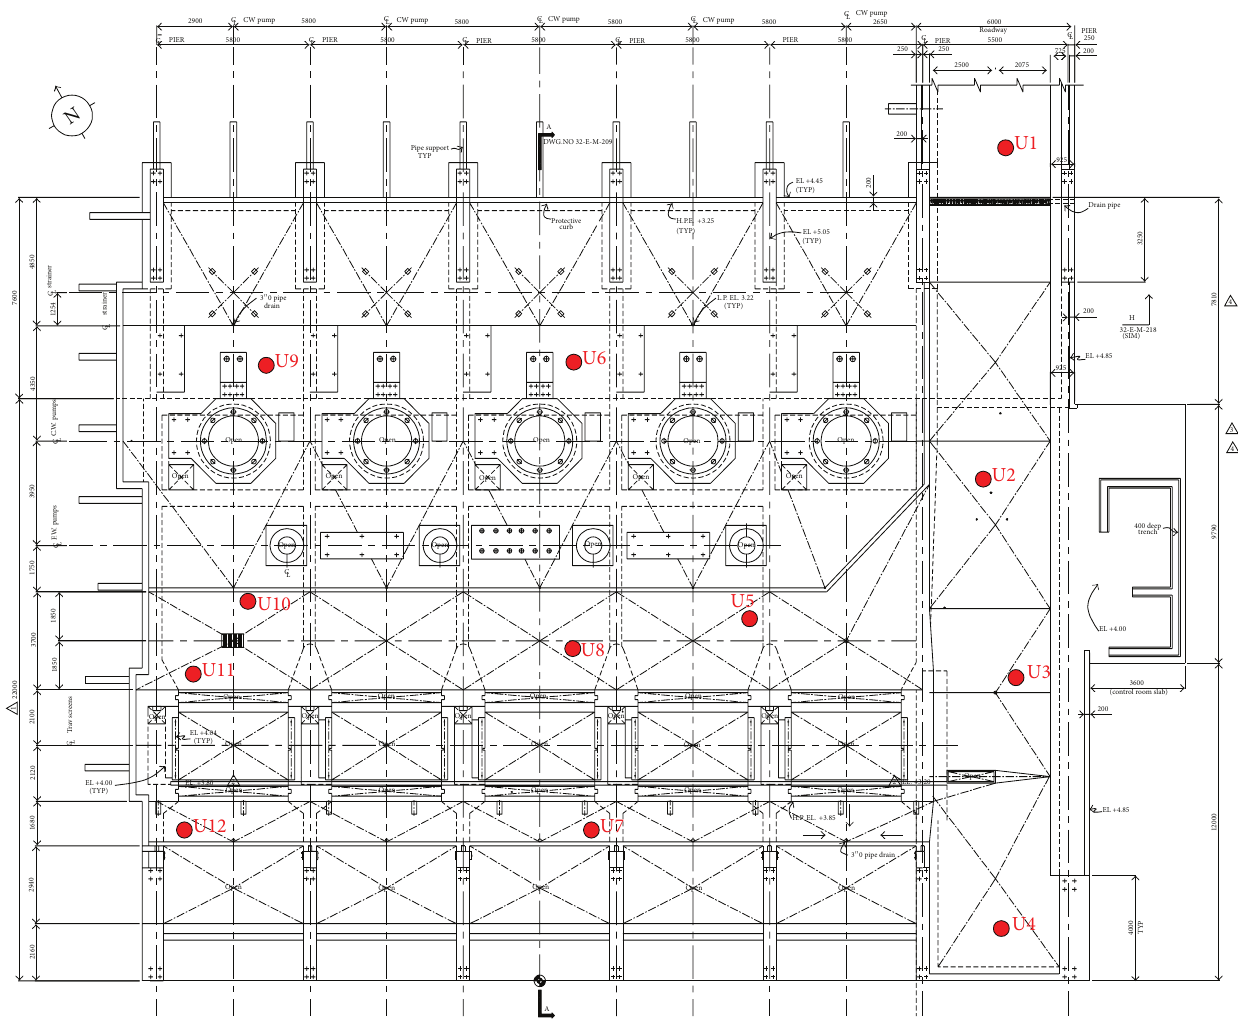
Figure 7: UPV test location at train